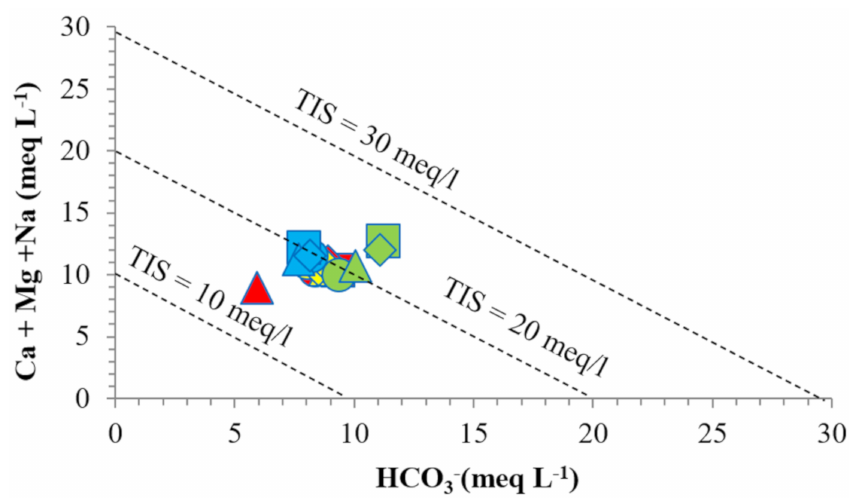
Figure 7. Correlation diagram of HCO 3 − and Ca + Mg +